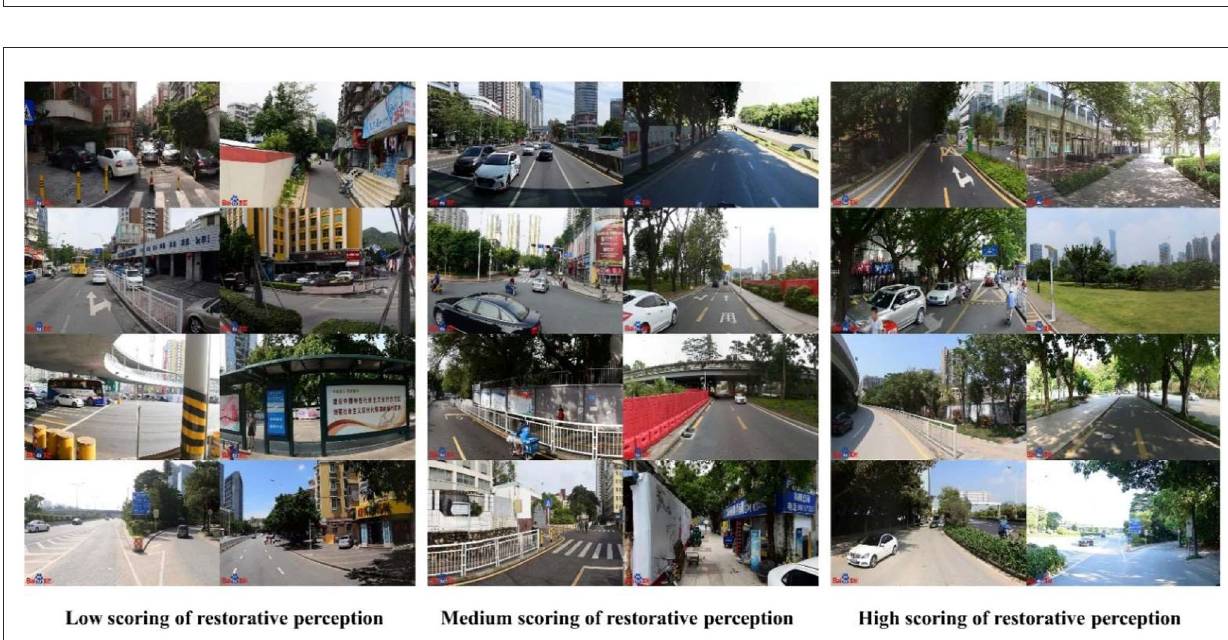
FIGURE5 Samples of labeled street view images classified by the machine learning model. Street view images that represent low scoring of restorative perception (left) ; street view images that represent medium scoring of restorative perception (middle) ; and street view images that represent low scoring of restorative perception (right)